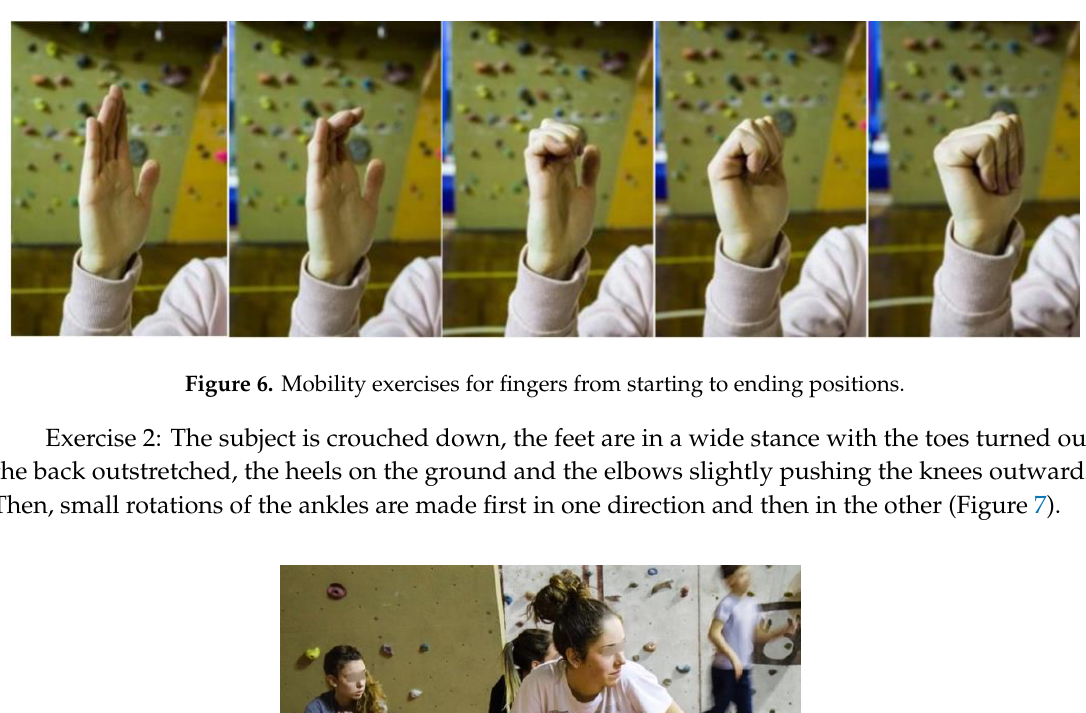
( b ) Figure 4. a. Starting position of the mobilization of the spine and coxo–femoral joint exercises. b. Ending position of the mobilization of the spine and coxo-femoral joint exercises. Exercise 3: In single foot support, rotate the rope forward without jumping. After rotating the rope forward, to pass the rope beyond the foot, flex the foot and then extend it. Do the same with the other foot (Figure 5).